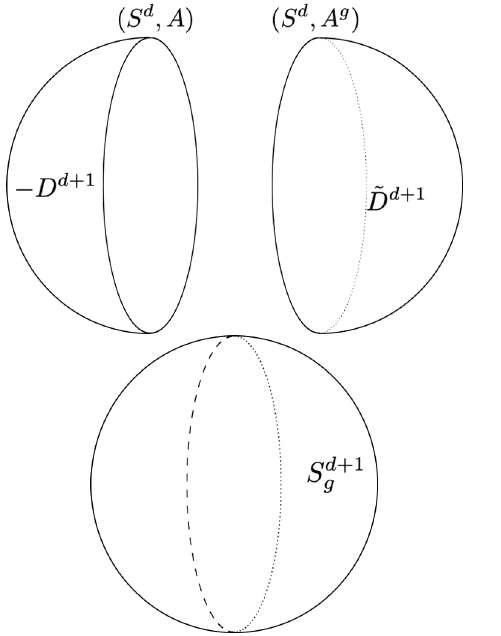
mapping sphere S d +1